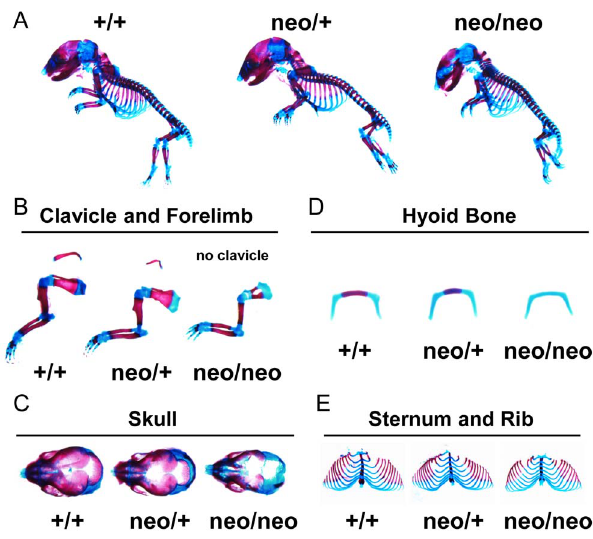
Figure 8. Runx2-I neo/neo mice showed severely delayed bone ossification. Skeletal tissues of E18.5 fetuses of wild-type ( + / + ), Runx2- I neo/ + (neo/ + ) and Runx2-I neo/neo (neo/neo) mice were stained with Alcian blue to detect cartilage, and Alizarin red to detect calcified bone. After whole-body images were captured (A), specimens were separated into parts: (B) clavicle and forelimb; (C) skull; (D) hyoid bone; (E) sternum and rib.